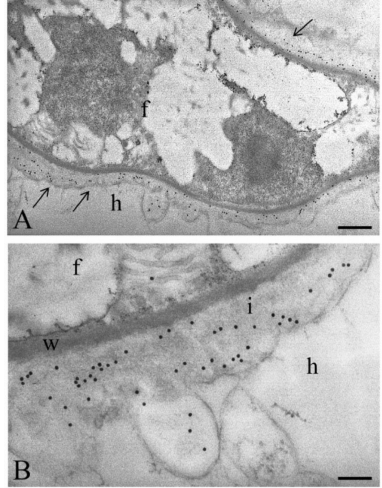
Figure 2. JIM5 labelling to localize homogalacturonans on ultra-thin sections of tomato root colonized by an arbuscular mycorrhizal fungus. ( A ) At the electron microscope level, a new apoplastic compartment (i.e., the symbiotic interface), based on host membrane proliferation, is evident around the intracellular hyphae. Gold granules (arrows) are present in the interface space around the intracellular fungus (f). Bar, 0.55 µ m; ( B ) Magnification of the interface region (i), labelled after treatment with JIM5. f, intracellular hypha; h, host cell; w, fungal cell wall. Bar, 0.15 µ